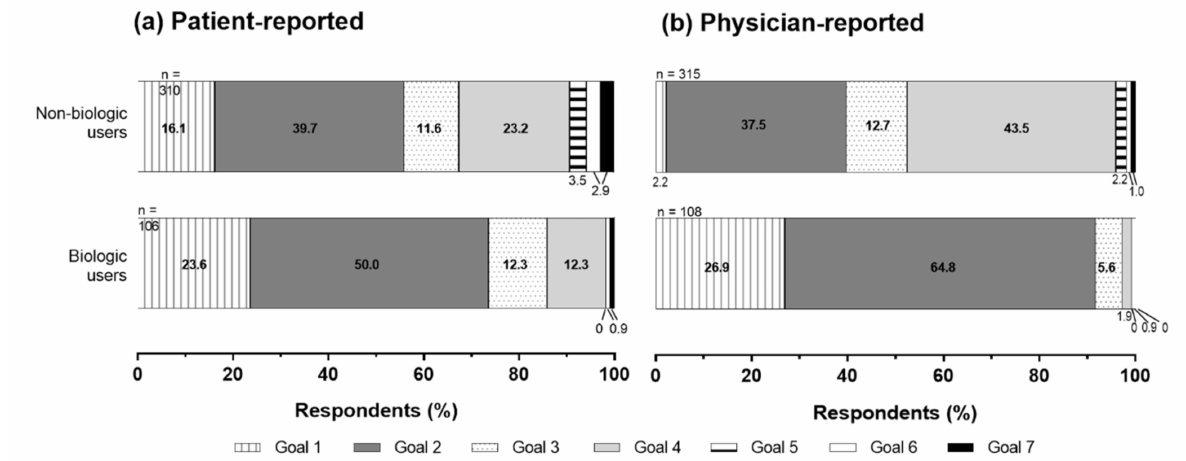
Figure 1. Patient- and physician-reported treatment goals. Goal 1 = complete clearance (Psoriasis Area and Severity Index (PASI) 100) [21], Goal 2 = almost complete clearance (PASI 90 to <100), Goal 3 = complete clearance at specific sites (nails, head, genitals, other), Goal 4 = improvement from previous treatment, but without “complete” or “almost complete clearance”, Goal 5 = relief from itchiness, Goal 6 = other goals, and Goal 7 = no particular goal set. ( a ) A larger number of patient (23.6% vs. 16.1%) and ( b ) physician (26.0% vs. 2.2%) among biologic users had higher treatment goals of achieving complete clearance.